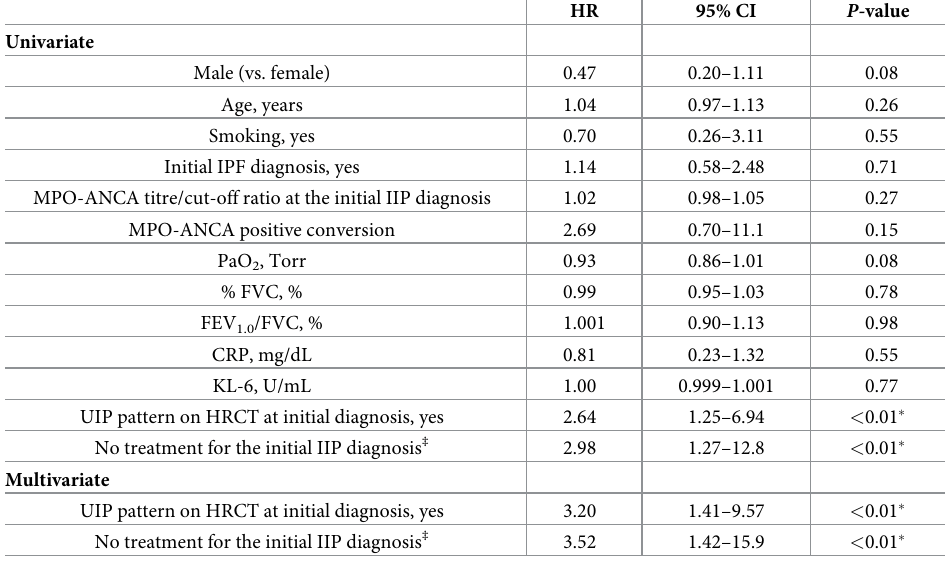
HR 95% CI P -value